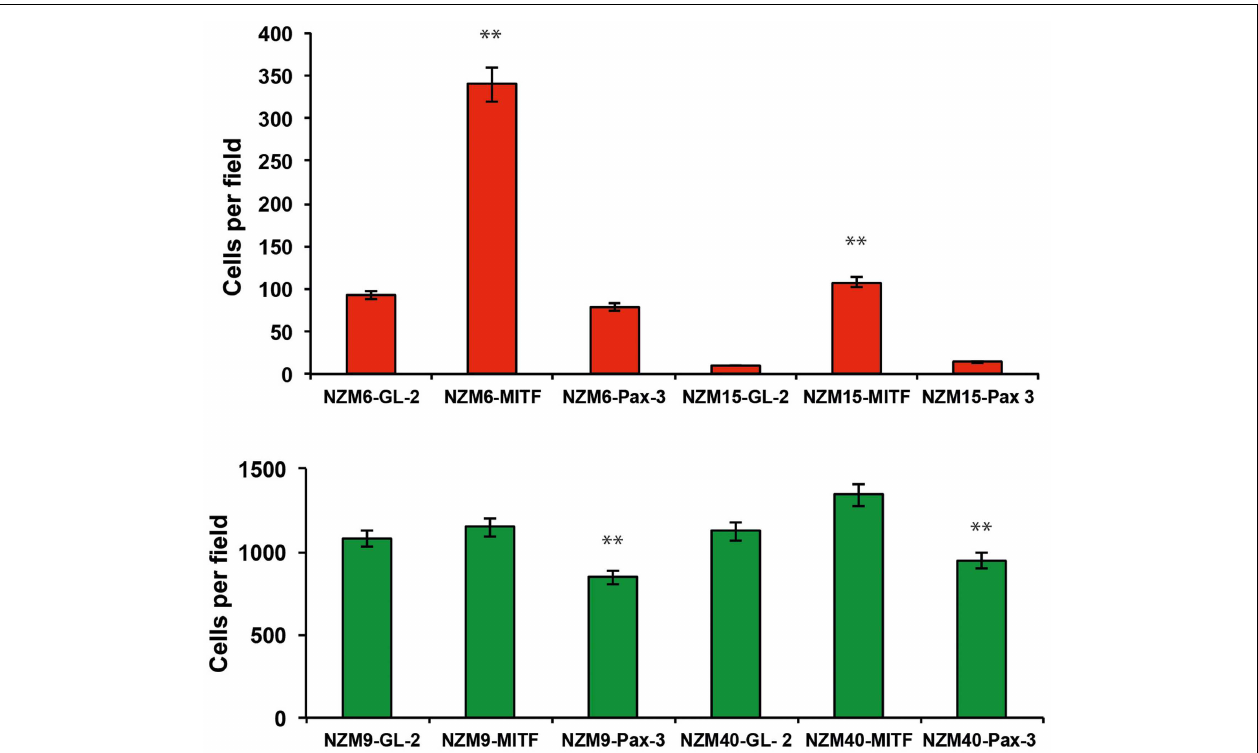
(red bars). Conversely, siRNA-mediated knockdown of MITF does not enhance the migration of melanoma cells expressing lower levels of MITF (green bars), but does enhance the migration of melanoma cells expressing high levels of MITF (red bars). ** p <